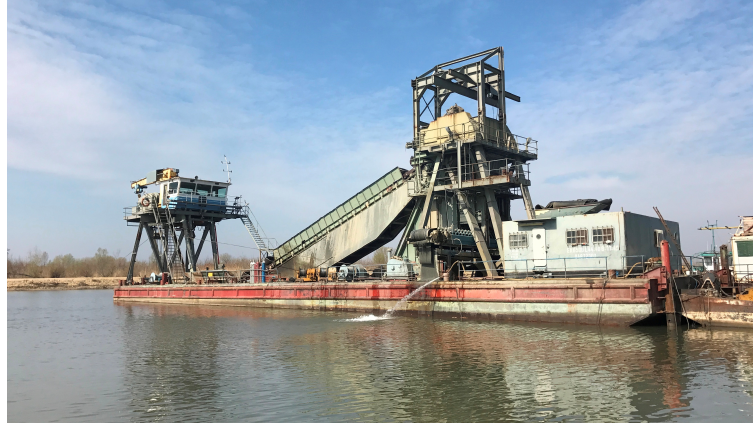
Figure 2. Bucket-chain dredger “5630”.